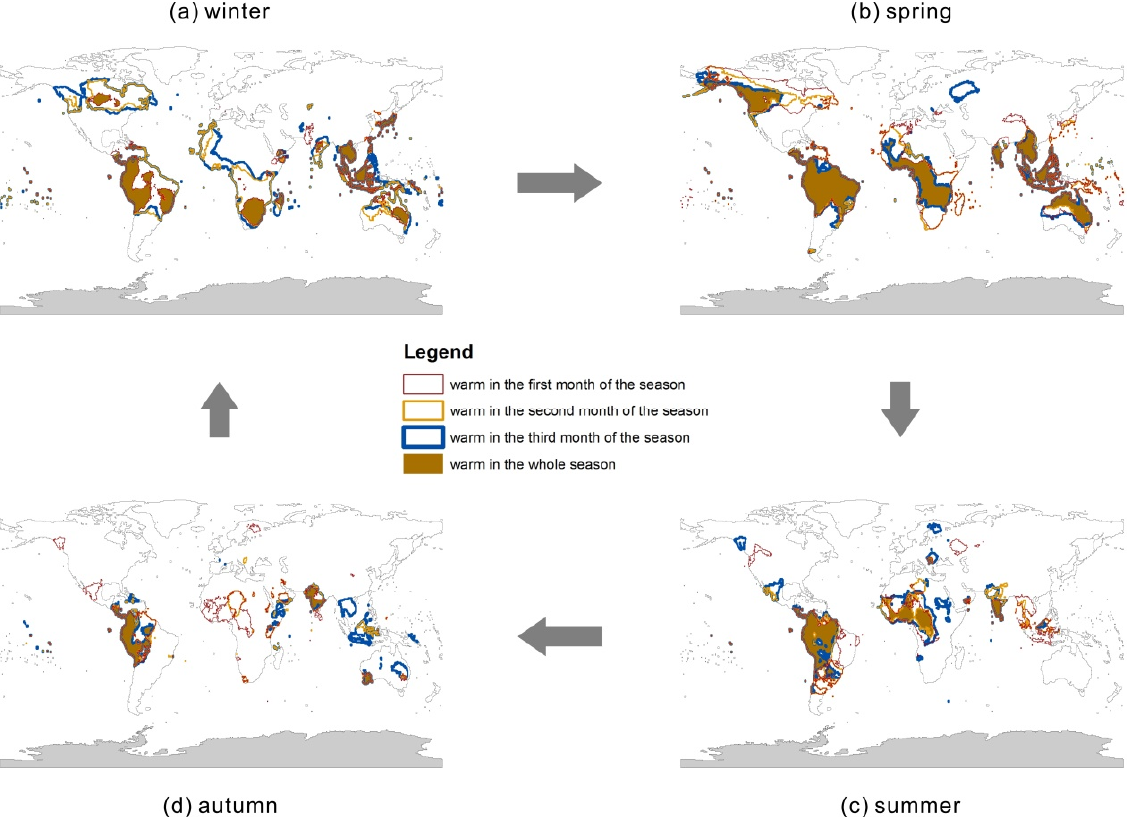
Figure 4. The warm flocks of the four seasons and the corresponding monthly flocks. ( a ) The flocks in boreal winter. ( b ) The flocks in boreal spring. ( c ) The flocks in boreal summer. ( d ) The flocks in boreal autumn. The widths of the lines for the monthly flocks are different, so that they do not cover each other when the monthly flocks share boundaries. The widths of the lines imply no other information.